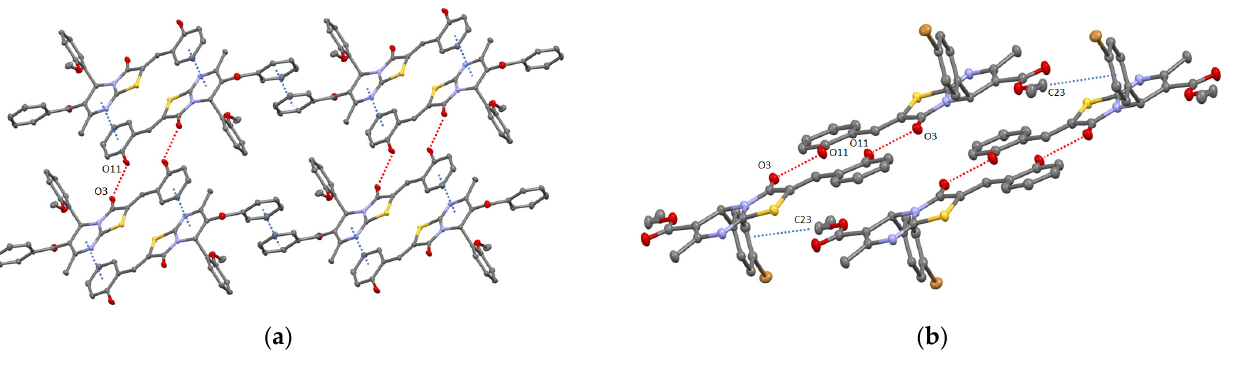
Figure 4. ORTEP view of crystal packing of 11 ( a ) and 12 ( b ) showing 2D layer and 1D chain formation resulting from both the intermolecular H-bonding and/or π – π /CH– π interactions (red and blue dotted lines, respectively). The ellipsoids are presented with 50% probability, H-atoms are omitted for clarity.